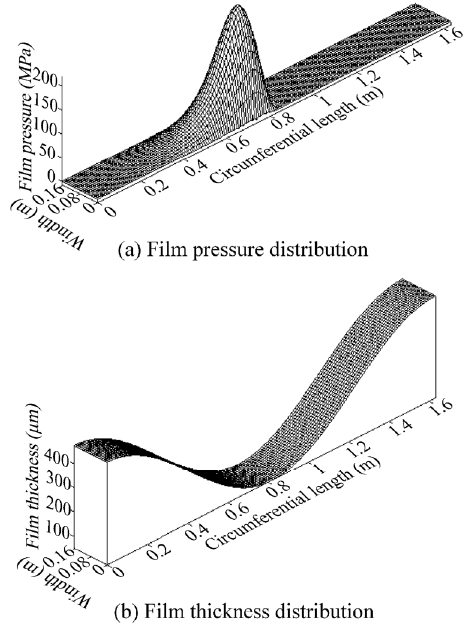
Fig. 8 3D pressure and film thickness distributions at the crank angle of 19 ˚ for the crank pin bearing with a clearance of 240 μ m and a lubricant temperature of 40 °